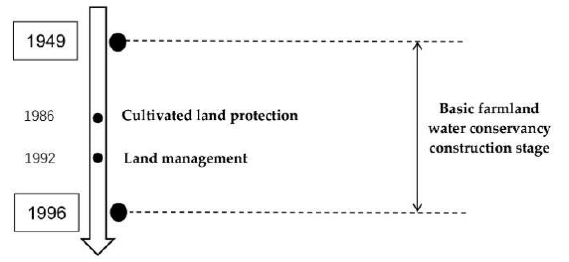
Figure 2. Schematic diagram showing development in the budding exploration stage.